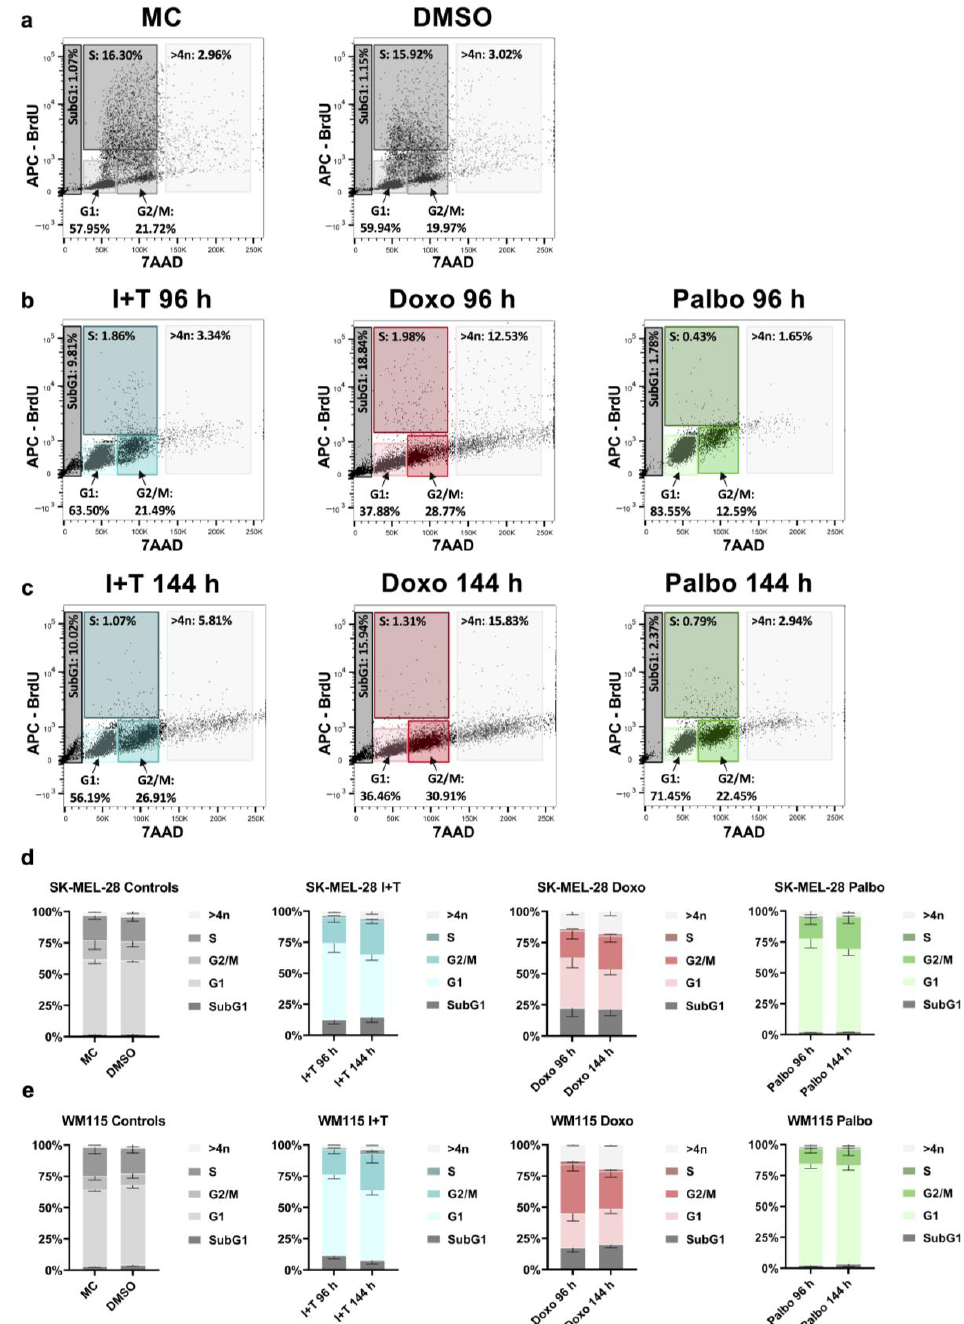
Figure 4. Differential cell cycle arrest induced by cytokines, doxorubicin, and palbociclib. ( a–c ) Representative plots depicting the distribution of SK-MEL-28 cells in different phases of the cell cycle (subG1, G1, S, G2/M, >4n) upon treatment with IFN- γ and TNF (I+T), doxorubicin (Doxo), and palbociclib (Palbo), and respective controls as indicated. MC, medium control. DMSO, vehicle control. Flow cytometric analysis was performed after the 96 h treatment ( a , b ) and 48 h after the end of treatment (144 h; ( c )). ( d , e ) Quantification of cell cycle phases (subG1, G1, S, G2/M, >4n) in SK-MEL-28 ( d ) and WM115 ( e ) melanoma cells after CIS or TIS. ( a–c ) Representative images from one of three experiments are shown. ( d , e ) Results are from three independent experiments ( n = 3) and show the mean ± s.d.; statistical analysis by two-way ANOVA shows a significant difference ( p < 0.05) between the S phase of each treatment at both time points and the respective controls ( p -values are indicated in Table